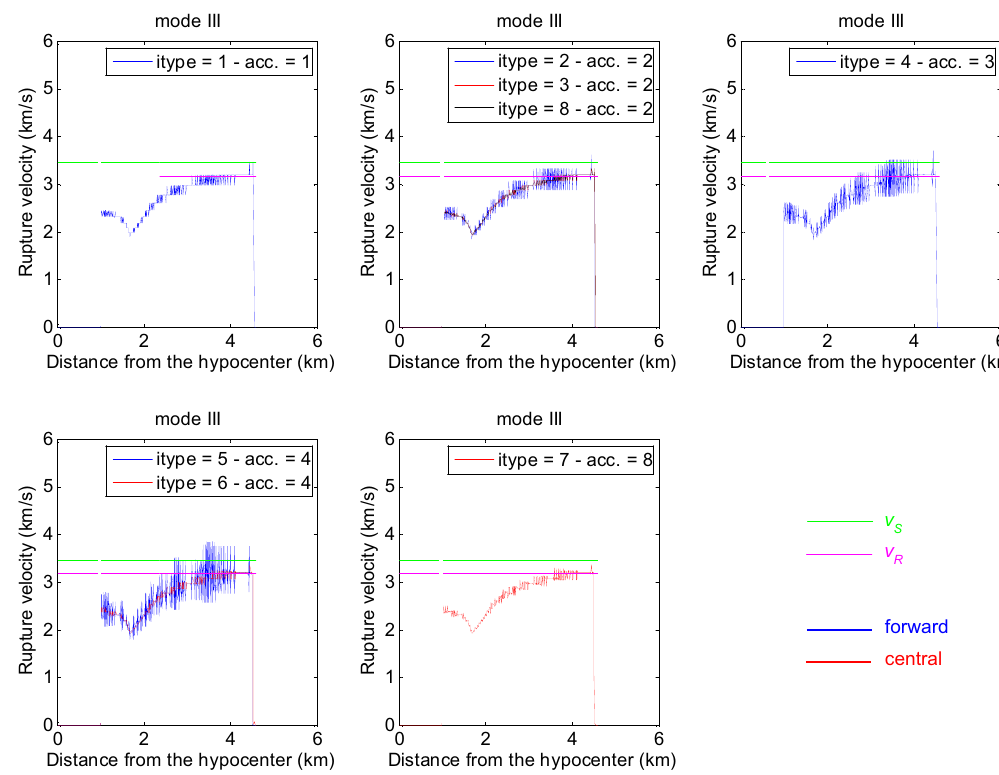
–direction (i.e., the propagation is basically mode 3